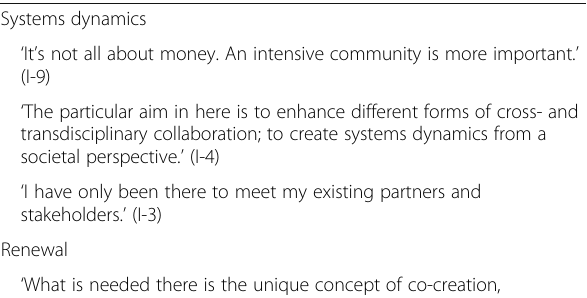
Table 6 Results, Layer 4 Co-developing the underlying mind sets and concepts directing the service ecosystem development Systems